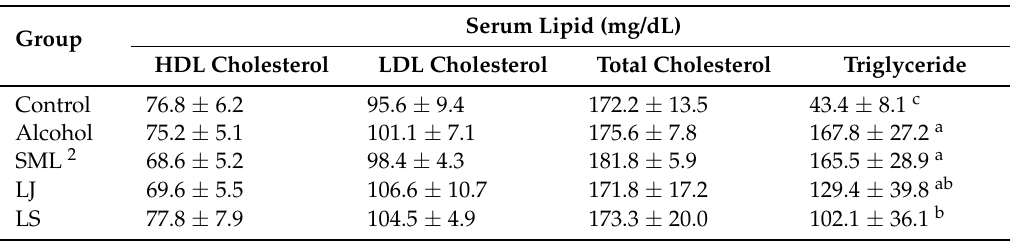
Table 1. Effects of heat-killed Lactobacillus salivarius (LS), Lactobacillus johnsonii (LJ) and silymarin (SML) on serum lipid levels in rats induced by alcohol 1